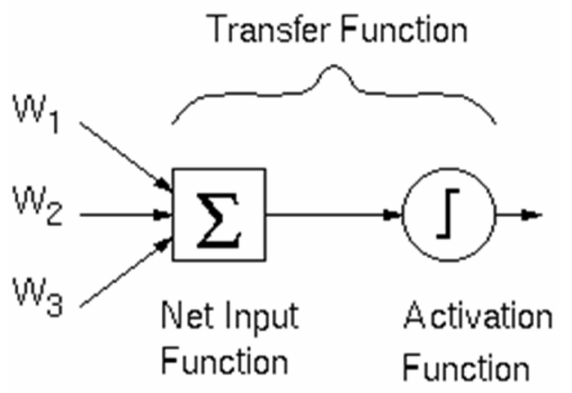
Figure 9. Multilayer Perceptron System [46].